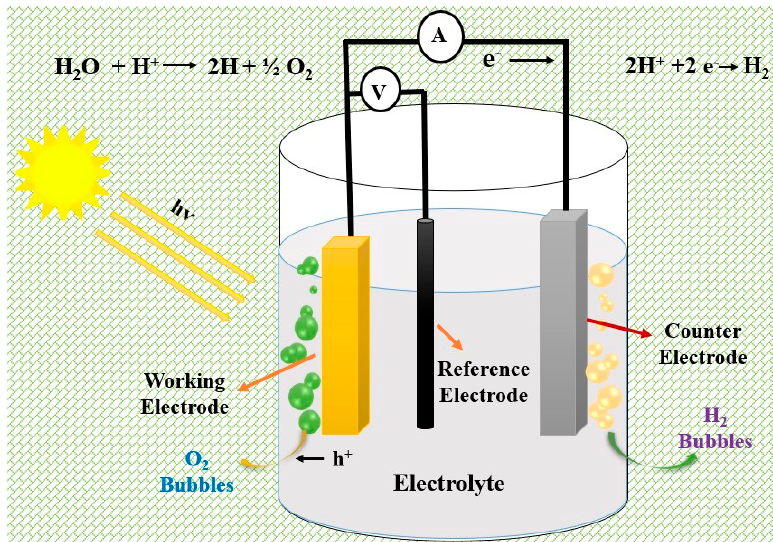
Figure 13. Schematic diagram of photoelectrocatalytic (PEC) water splitting.